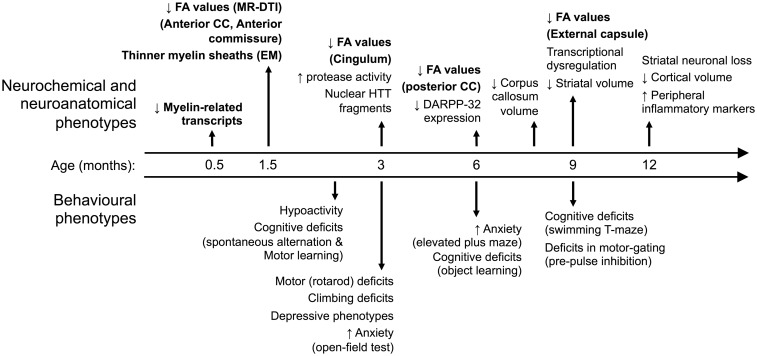
Time-course of behavioural, neurochemical and neuroanatomical phenotypes in the YAC128 HD mice. YAC128 HD mice manifest phenotypes that mimic several features of human HD including progressive motor and cognitive deficits, and depressive and anxiety-like behaviours. The YAC128 mice develop neuropathological changes reminiscent of HD including not only preferential striatal atrophy but also early myelination and white matter abnormalities. The YAC128 phenotypes identified in the present study are shown in bold.